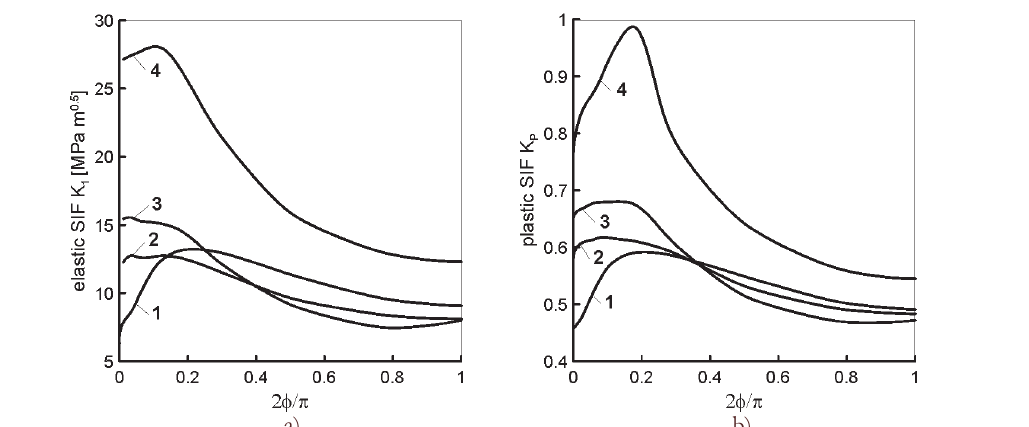
Figure 9: Elastic (a) and (b) plastic stress intensity factor distributions for bending plate along crack front (1-initial, 2-3-intermediate, 4- final).